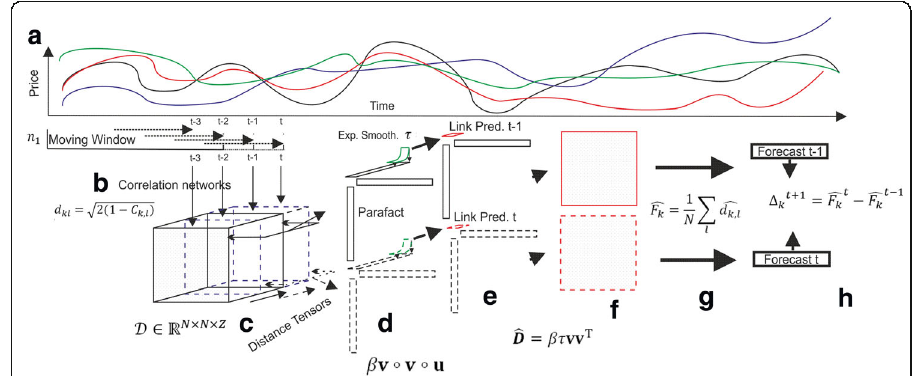
Fig. 1 Graphical representation of the method. Starting from stock price time series ( a ), a rolling window is applied to compute the correlation among each pair of stocks ( b ). At each time step a distance matrix is created. Once the rolling window has produced Z distance matrices, those matrices are embedded into a 3D-tensor ( c ). When the steps of the moving window exceed Z, the tensor is allowed to move in time with each new step, as new data are available ( c - solid line vs. dashed line ). This temporal shift of the tensor permits to compare the forecasts produced by two consecutive decompositions and generates a signal whose sign indicates the future direction of the stock prices. For graphical purposes, the decomposition of two consecutive tensors and the resulting links prediction are drawn using solid and dashed lines. The two consecutive tensors are approximated as the linear combination of three vectors ( d ) representing spatial ( v ) and temporal ( u ) relationships between stocks; D ≅ β v ∘ v ∘ u . The exponential smoothing ( d - green lines ) applied to u extracts a scalar τ representing the forecast of temporal profile for the next period ( e - red squares ). The forecast of the future distance matrix is obtained as a linear combination of the two spatial dissimilarity vectors, the parameter β and of the forecast τ of the temporal profile vector; D ¼ τβ vv T ( e and f - red squares ). Finally, the connection intensity of each asset is quantified via a centrality score by summing the distances that link each asset to the others ( g ). The signal for each stock is obtained as the difference between the centrality values obtained in two predictions ( h